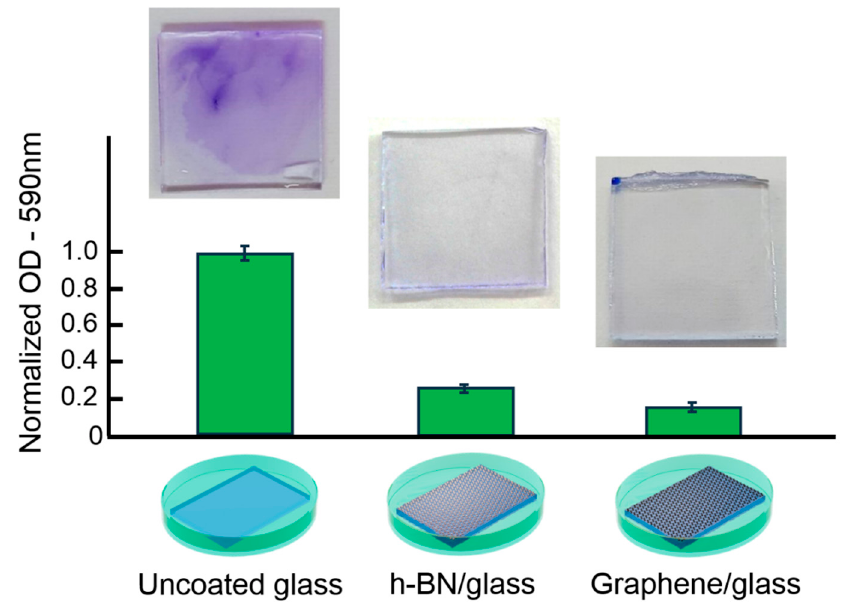
Figure 4. Optical density (OD) and crystal violet results for E. cloacae biofilms grown on uncoated glass, h-BN-coated glass, and SLG-coated glass samples.